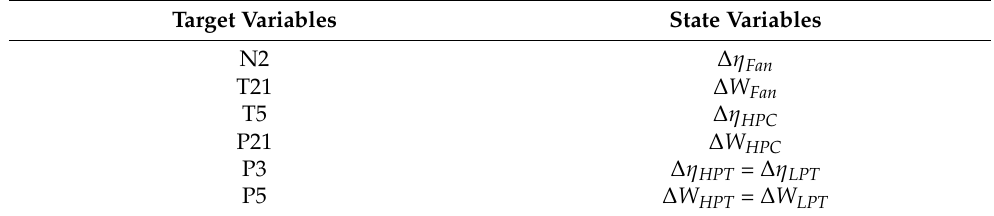
Table A2. Determined solver, limited sensor